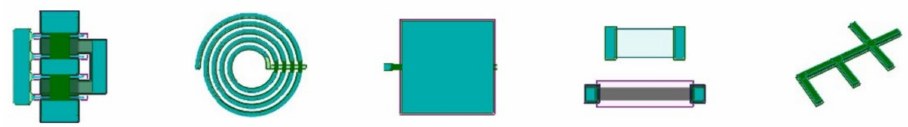
Figure 8. Topological models, as shown in AWR Microwave Office, from left to right: pHEMT, circular spiral inductor, capacitor, resistors, transmission